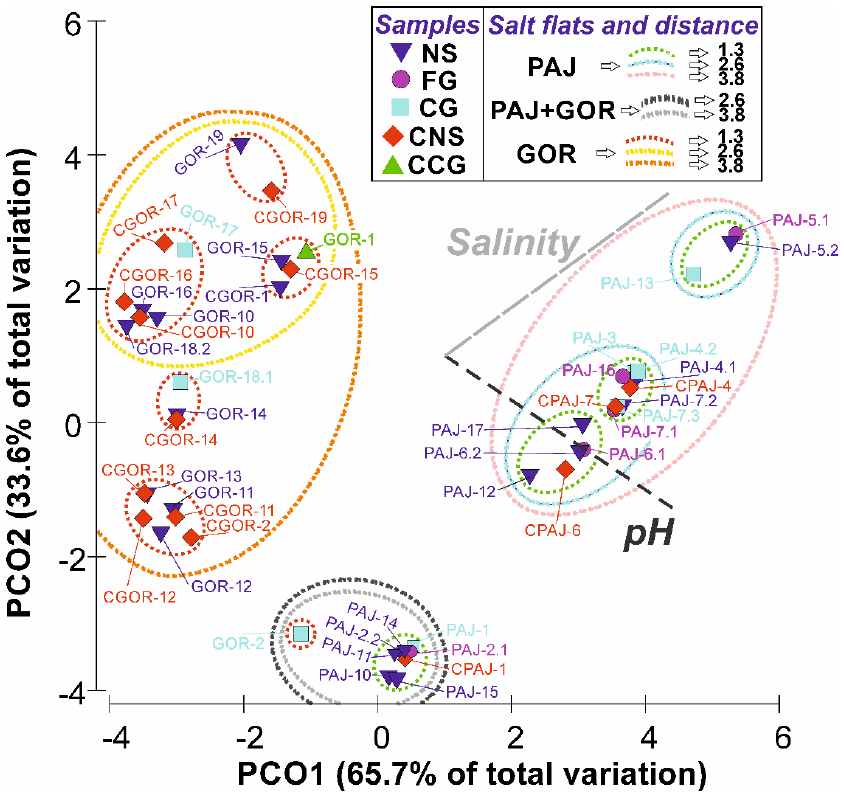
Figure 5. Principal coordinates analysis (PCO) the Euclidian distance matrix of normalized data (pH and salinity from the beginning of the experiment) between samples: no substrate (NS), fine gypsum (FG), coarse gypsum (CG); and controls: control with no substrate (CNS), control with coarse gypsum (CCG) from Salar de Pajonales (PAJ) and Salar de Gorbea (GOR) during the incubation time. The graph shows the meaningful relationship (distance) between samples as close (1.3), intermediate (2.6), and distant (3.8). Samples with high salinity and pH values loaded positively on the PCO1, whereas low-salinity and low-pH values loaded negatively on